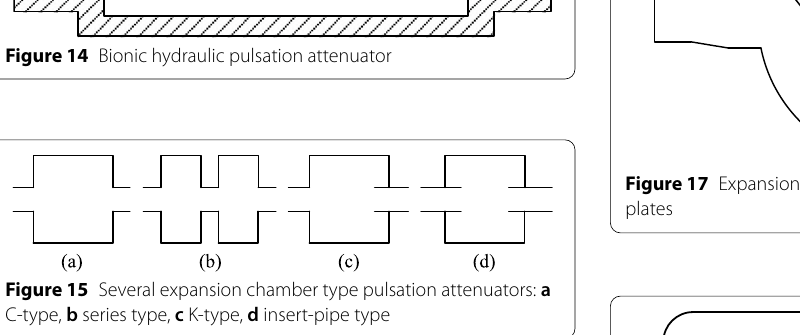
Figure 15 Several expansion chamber type pulsation attenuators: a C-type, b series type, c K-type, d insert-pipe type